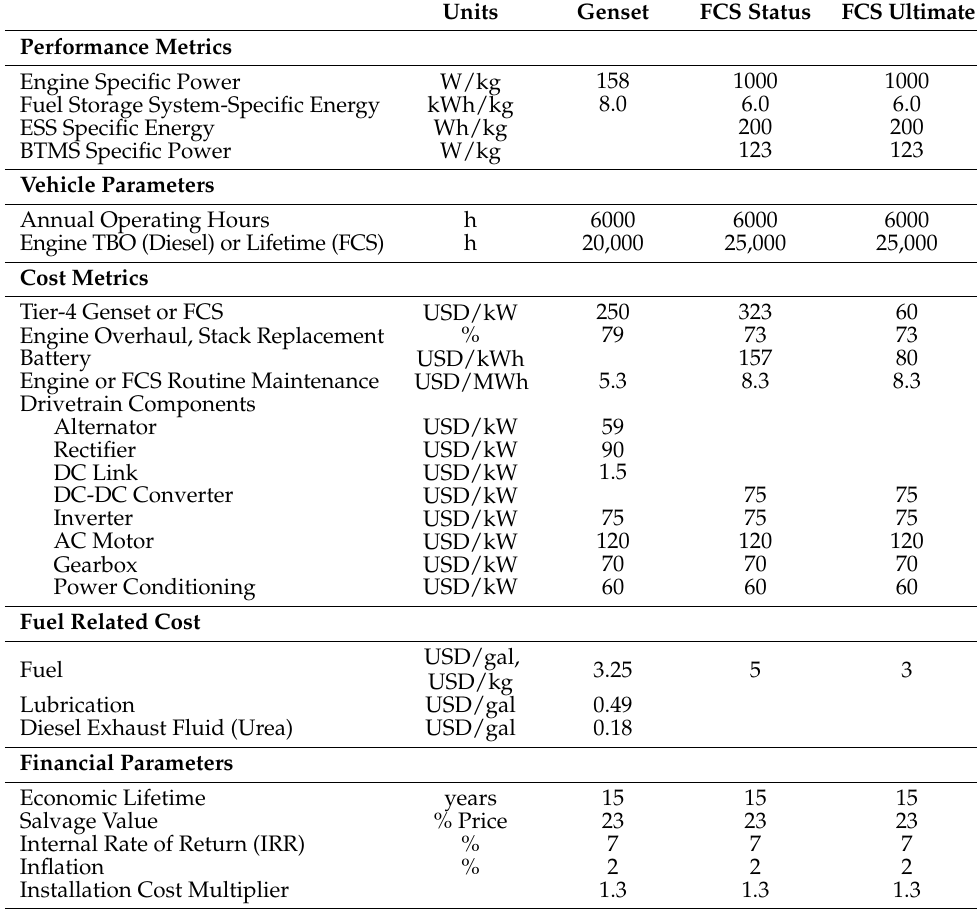
Table 2. Performance and cost metrics for diesel genset, status FCS, and ultimate